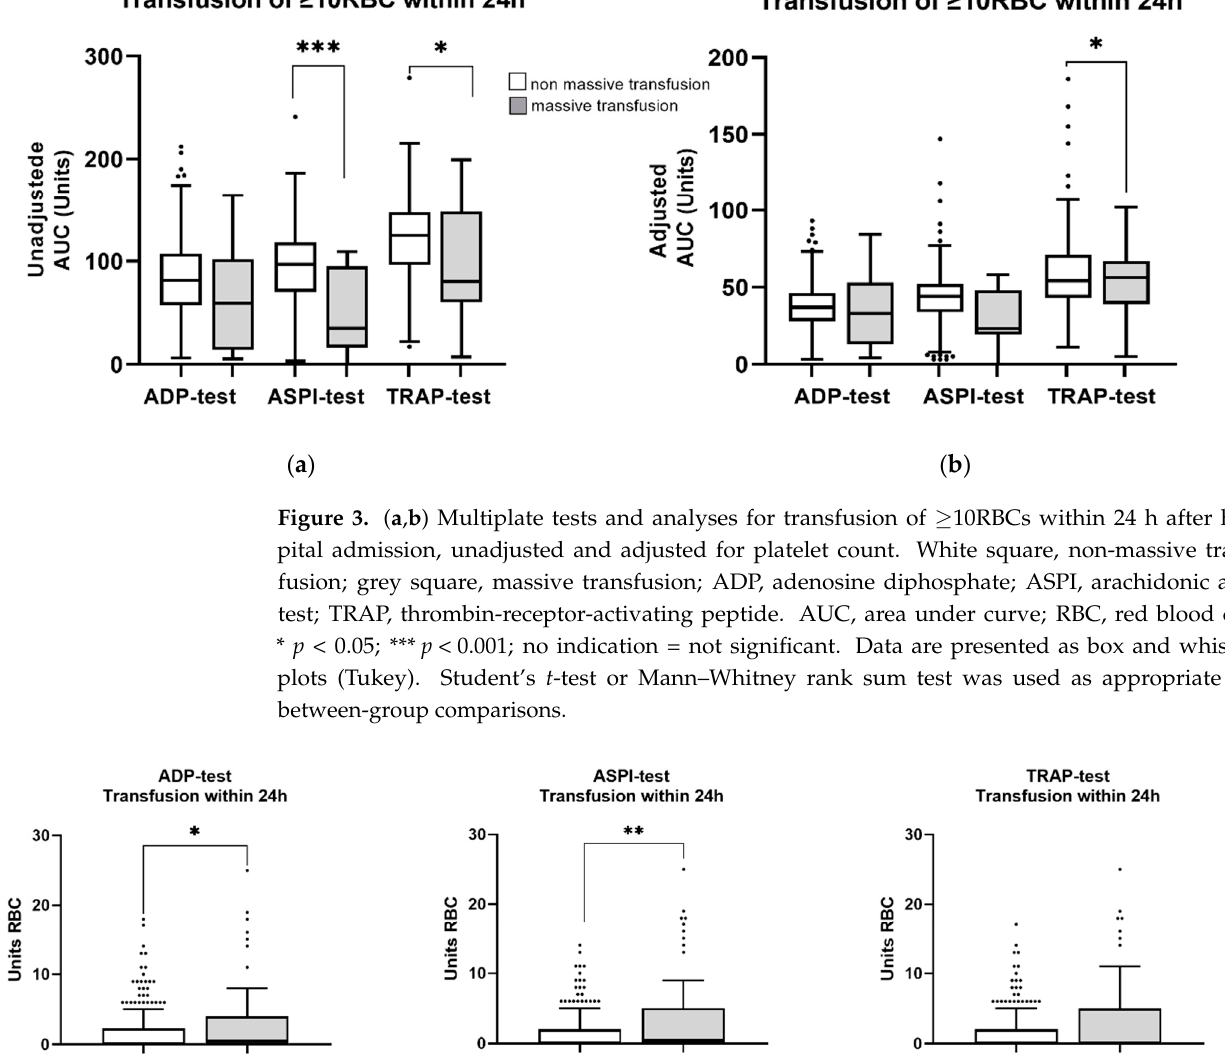
7 of 12 Figure 2. ROC curves for transfusion of ≥ 10 RBCs within 24 h adjusted for platelet count. ADP, adenosine diphosphate; ASPI, arachidonic acid test; TRAP, thrombin-receptor-activating peptide; ROC, receiver operating characteristics.